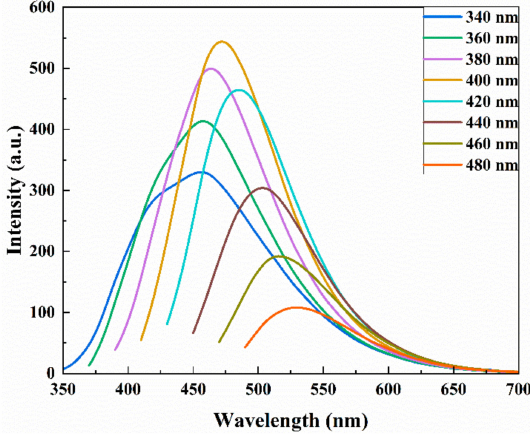
Figure 6. Excitation wavelength-dependent FL emission spectra of the